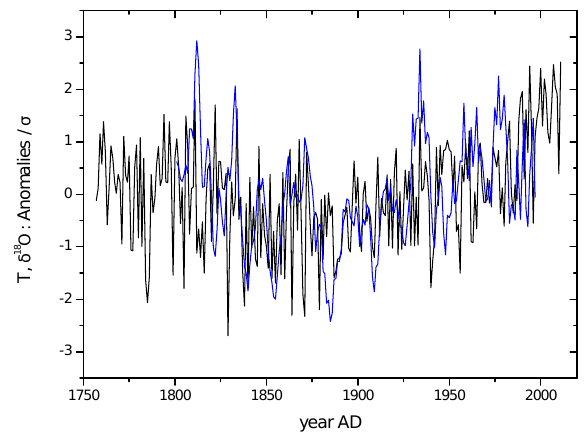
Fig. 2. Northern Hemisphere (Central European) instrumental tem- perature averaged record M6 (black) together with the Antarctic ice core record IC (blue) as a SH counterpart, each as an anomaly di- vided by the standard